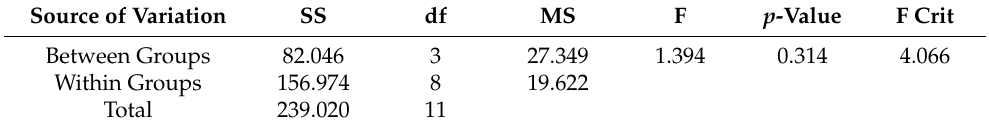
Table 3. One-factor ANOVA for effect of treatment on moisture content ( p = 0.05). Source of Variation